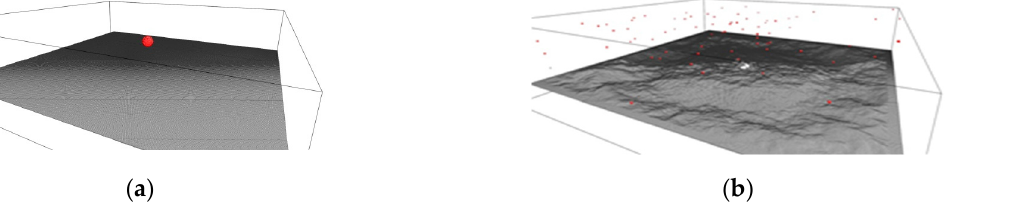
Figure 1. Simulation snapshots of argon cluster bombardment on a graphene sheet with the cluster at different timesteps: ( a ) 0 fs; ( b ) 100,000 fs.